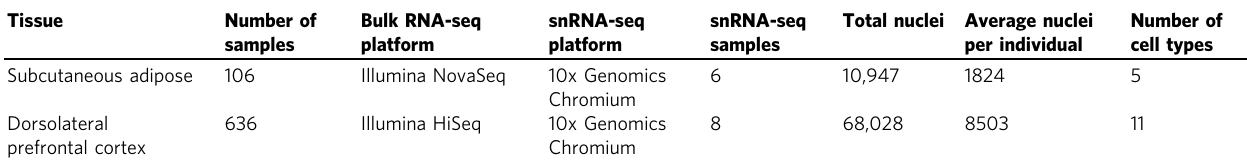
Table 1 Summary of snRNA-seq and bulk expression datasets used for benchmarking Bisque and existing